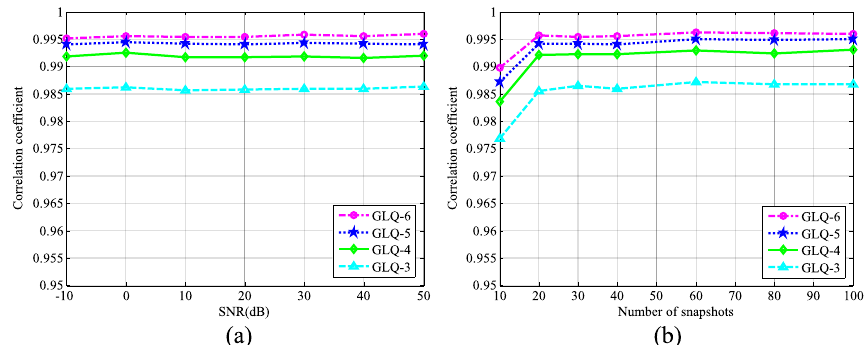
Fig. 3 Comparison of correlation coefficient values. a Correlation coefficient for covariance matrix under different GLQ orders against SNR. b Correlation coefficient against number of snapshots